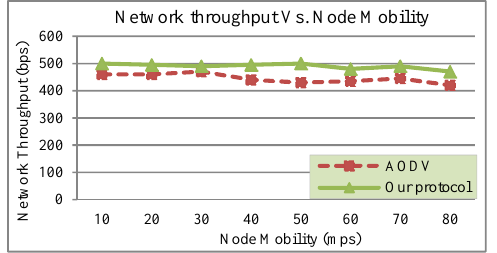
Fig. 8. Network Throughput Vs. Node Mobility